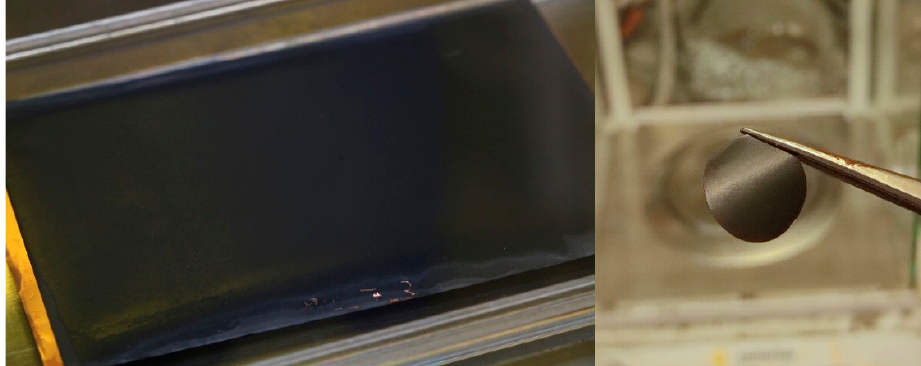
Figure 2. Polymer electrolyte layer on graphite electrode directly after polymerization ( left ) as well as a punched-out membrane on a LiNi 1/3 Mn 1/3 Co 1/3 O 2 electrode for tests in a coin cell ( right ).